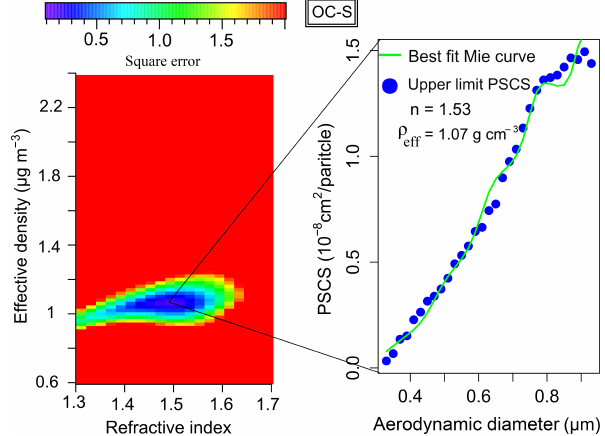
Figure 1. SSE distribution of fitting between measured and theoret- ical PSCS as a function of n and ρ eff (left), and measured and best fit theoretical PSCS as a function of d va (right) for